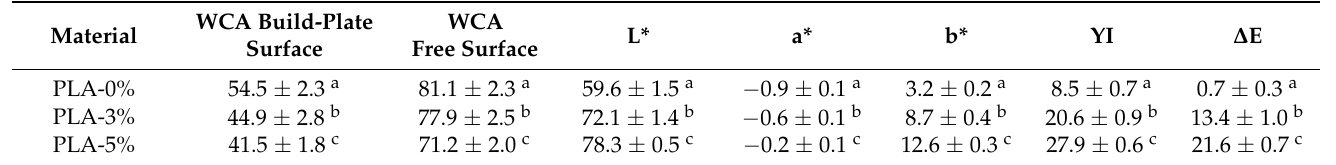
Table 6. Water contact angle (WCA) and color parameters for the CIEL*a*b* space for PLA-0%, PLA-3%, and PLA-5% CaCO 3